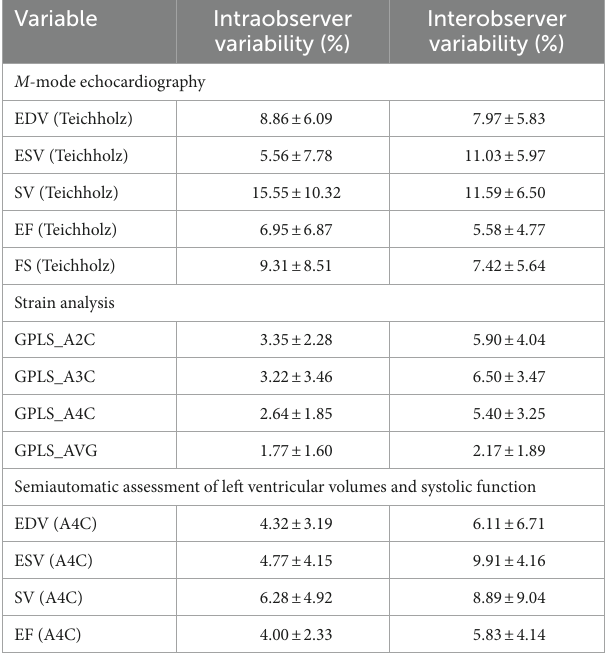
TABLE 5 Relative intra- and interobserver variability of echocardiographic variables. Variable Intraobserver Interobserver variability (%) variability